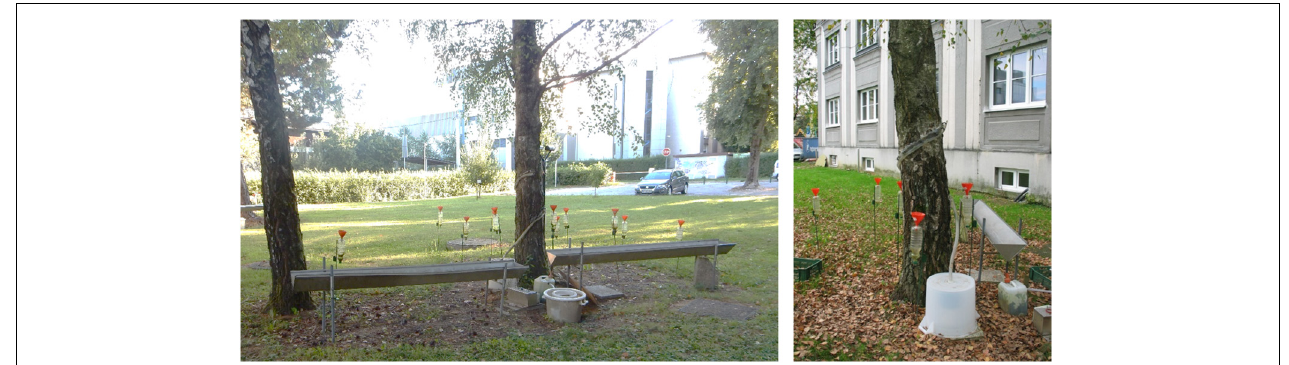
FIGURE 1 | Study plot (left) and measurements of the stemflow at the selected birch tree (right)